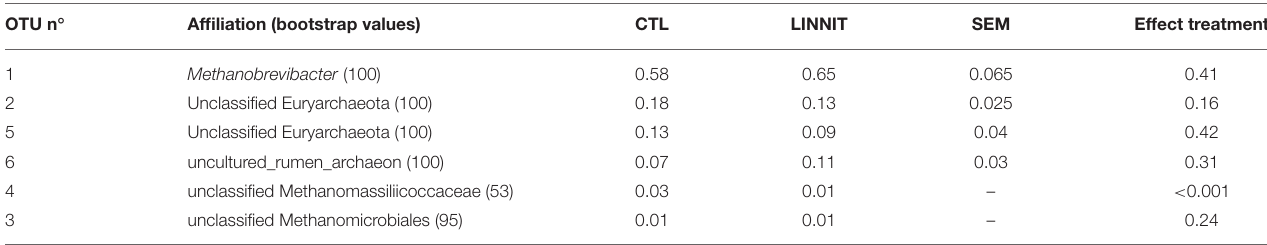
TABLE 5 | mcrA cDNA relative abundance proportions in the rumen of bulls receiving a control (CTL) or linseed plus nitrate (LINNIT) supplemented diet; only the six most abundant OTUs (clustering at 97% of similarity) are presented, regrouping 99% of sequences. OTU n ◦ Affiliation (bootstrap